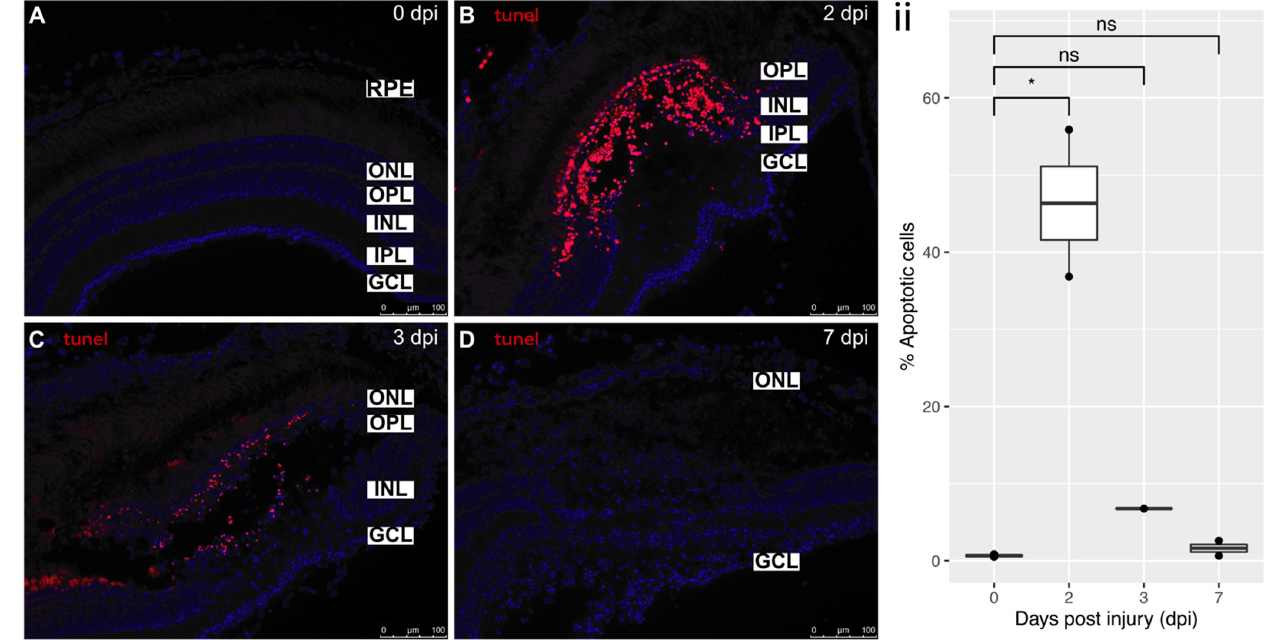
Figure 3. TUNEL staining: ( i ) ( A ) Control staining in uninjured retina (0 dpi). ( B ) 2 dpi: profound localized cell death in the area of cryoinjury, degeneration phase. Predominantly affected layers were OPL and INL. ( C ) 3 dpi: cell death still ongoing, but to a lesser extent than at 2 dpi, clearing off the dead cells by macrophages. ( D ) 7 dpi: damaged nuclei are no longer detected in the retina, reprogramming of MG, remodeling phase. All sections were counterstained with DAPI. Apoptotic cells—TMR Red; Nuclei, DAPI—blue. Retinal layers labelled in control panel for reference; RPE—retinal pigment epithelium, ONL—outer nuclear layer, OPL—outer plexiform layer, INL—inner nuclear layer, IPL—inner plexiform layer, GCL—ganglion cell layer. Scale bars represent 100 µm. (ii) Relative percentage of apoptotic cells at each time-point (n = 2), * p value = 0.02.